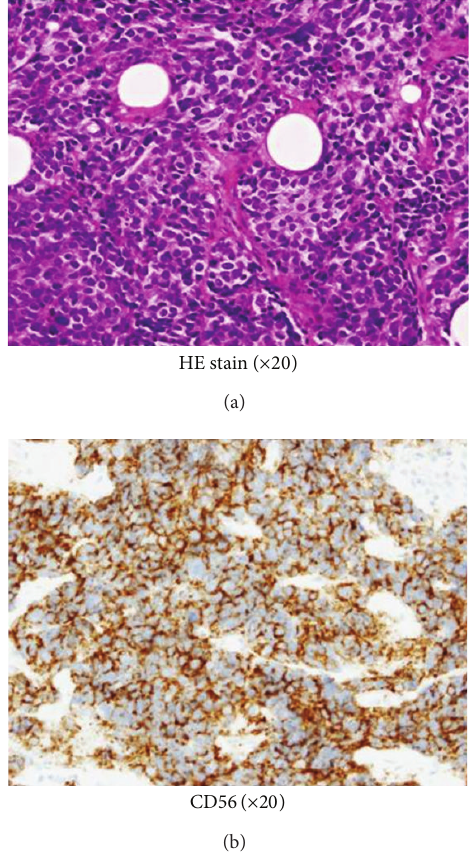
Figure 6: (a) The tumor showed a solid medullary growth pattern consisting of small-sized epithelial dysplasia. (b) Results of CD56 staining were